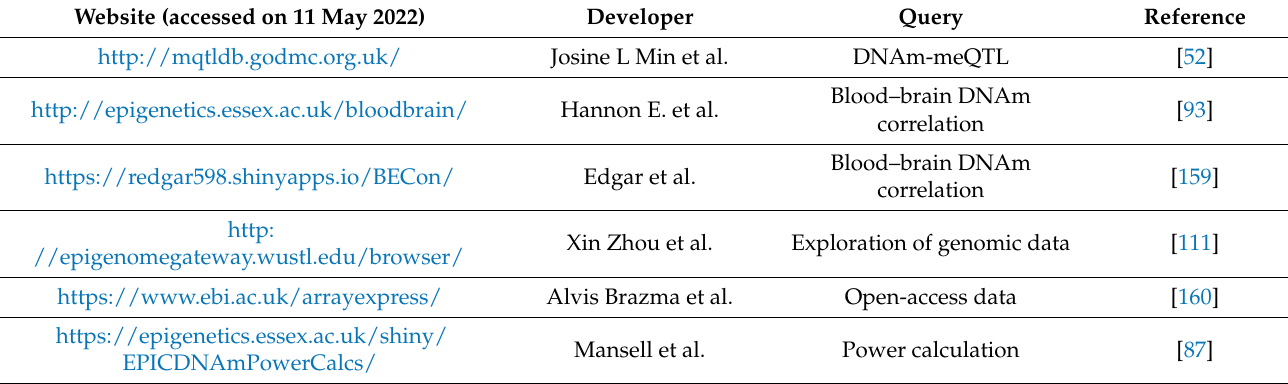
Table 1. Web-based tools for an epigenetic